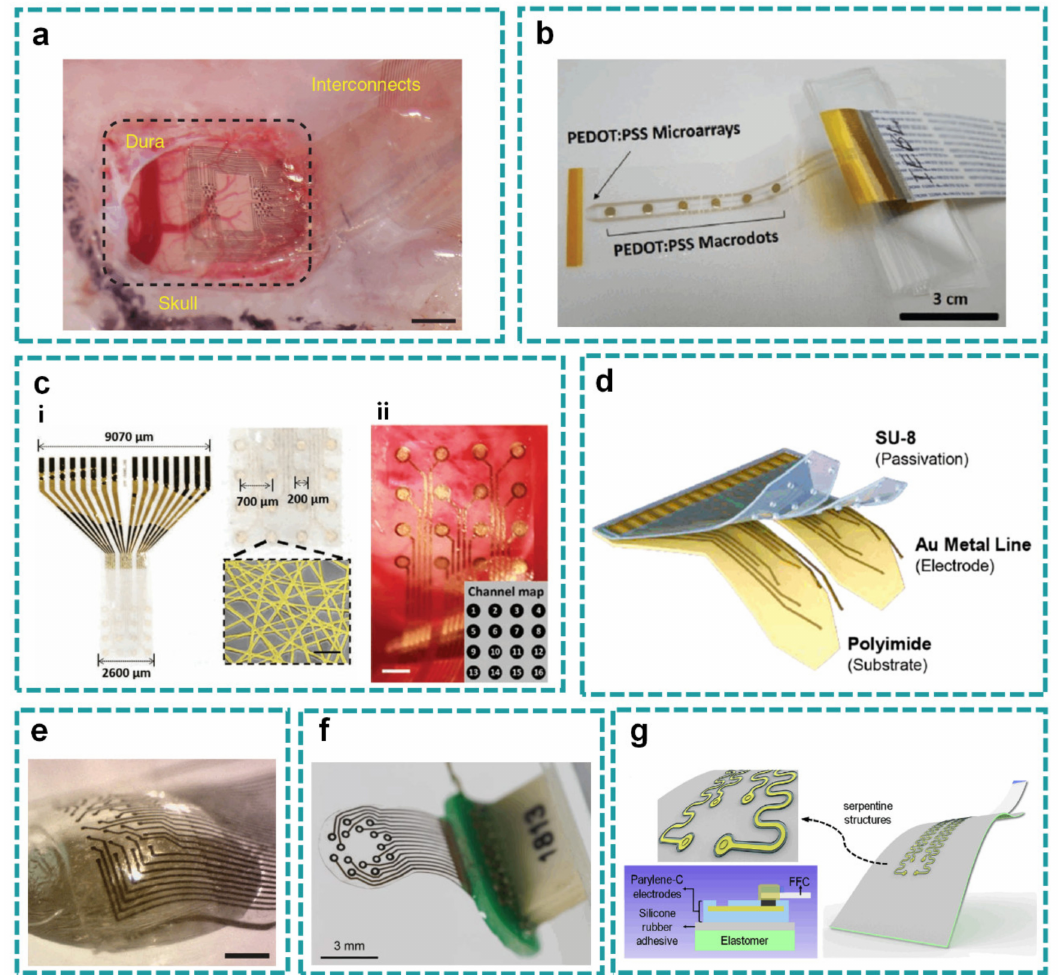
Figure 2. Planar layout. ( a ) a representative flat ultrathin electrode array with good biocompatibility, high density and ultra-thin thickness; scale bar, 1mm (reprinted with permission from [68]); ( b ) a parylene-based planar array